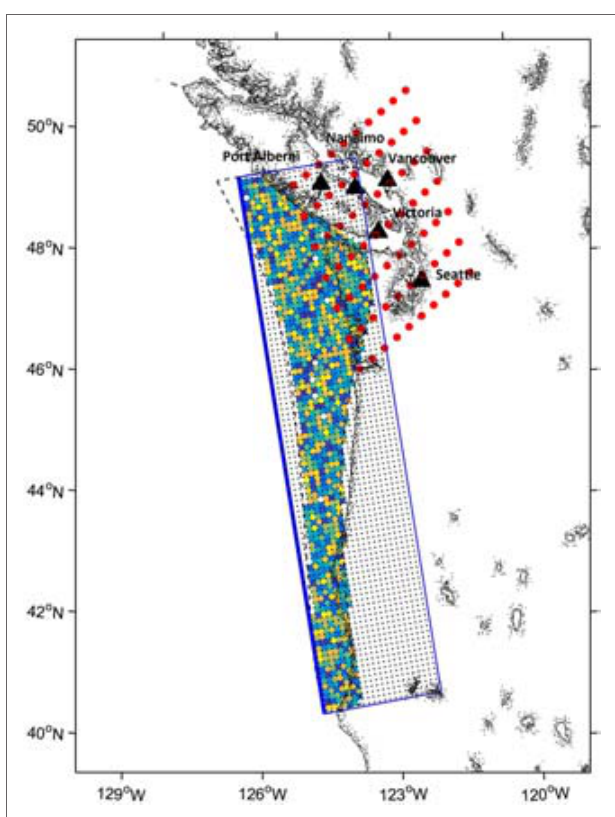
FIGURE 4 | Locations of observation sites (red circles) and slip distributions for the random model (colorful circles distributed on the subducting interface). Black triangles show the location of major cities. Subsources within the fault boundary (dashed black polygon) have randomly generated relative slip inputs, while those outside the boundary but inside the overall fault plane (blue rectangle) are assigned near-zero values.